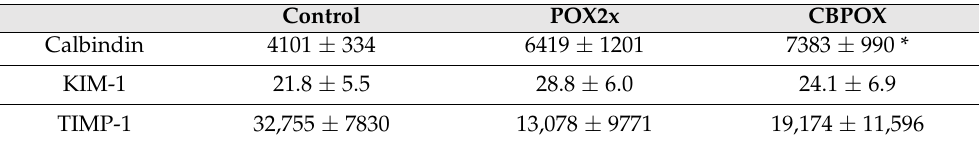
Table 1. Calbindin, KIM-1, and TIMP-1 in daily urine of rats 3 days after exposure to POX.